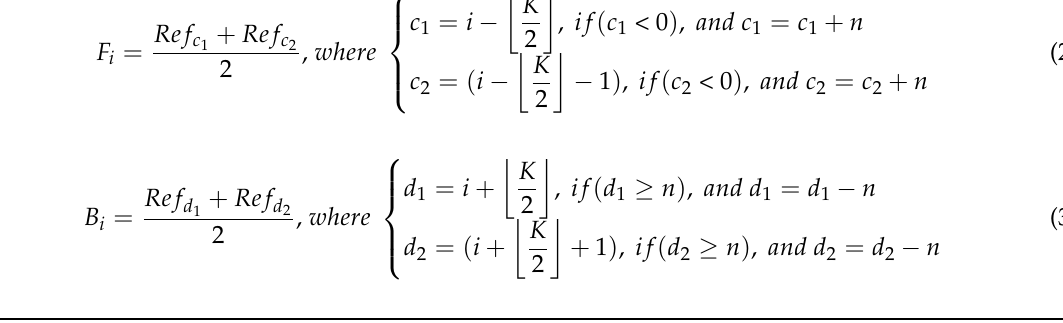
Algorithm 1: Calculation of F i and B i for the r -th round of time duration T r .